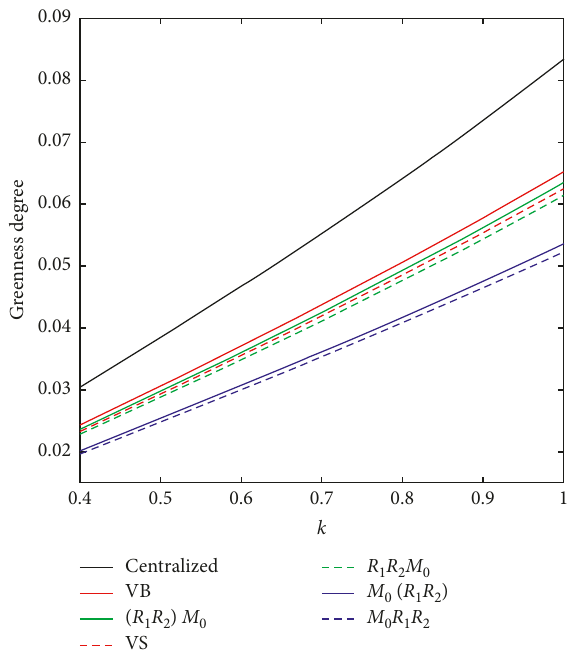
Figure 1: Effect of k on the product greenness in centralized and decentralized models.